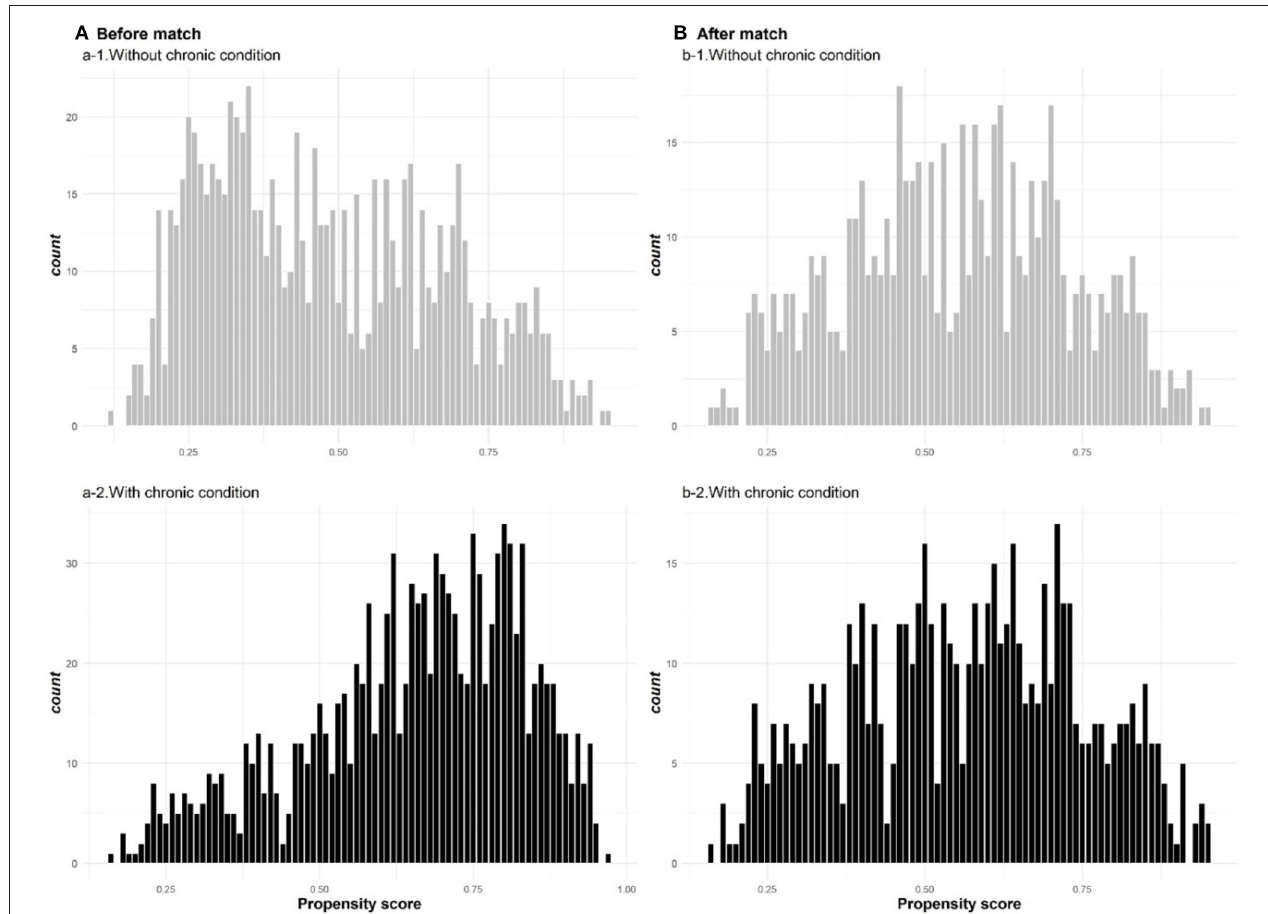
FIGURE 1 | The distribution of propensity scores for participants with and without chronic conditions before (A) and after (B)